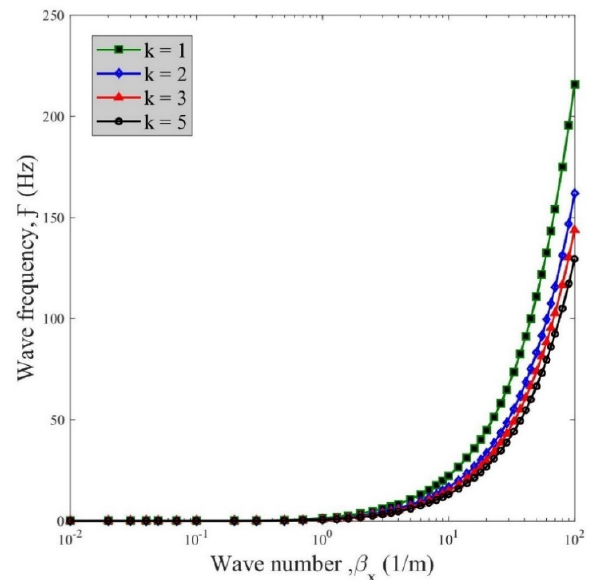
Figure 4. Wave frequency vs. wave number for different values of k .